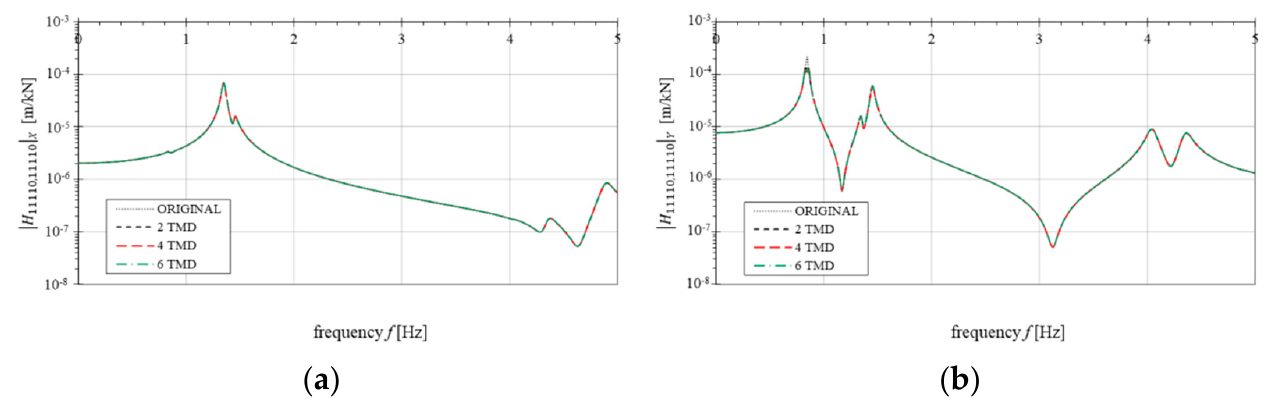
Figure 21. Module graph of the FRF in node 11,110 for optimal TMD parameters ( J 1) and a different number of TMDs: ( a ) for X direction; ( b ) for Y direction.